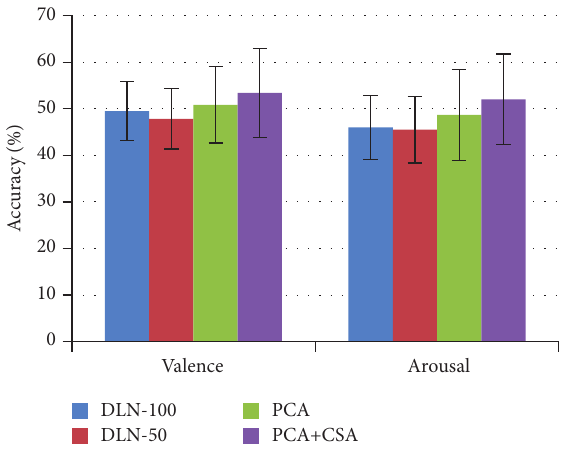
Figure 13: Average accuracy of the